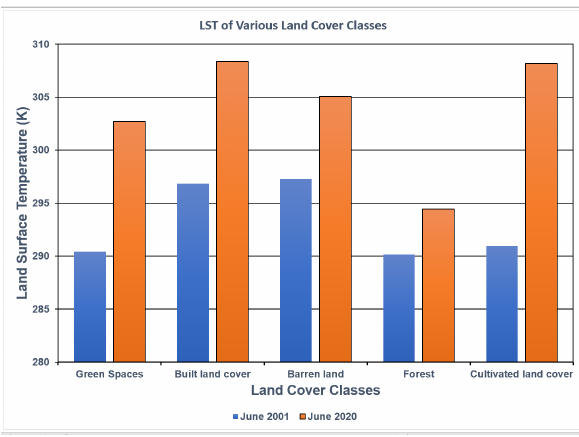
Figure 3. LST Variation across land cover classes Further, the LST values of the selected land cover classes in 2001 and 2020 were analysed to assess the change in LST. Results of this analysis indicate an increase in LST in all the selected land cover classes. The percent increase varied anywhere from 1.5 to 6. The percent increase in LST is shown in Table 2.